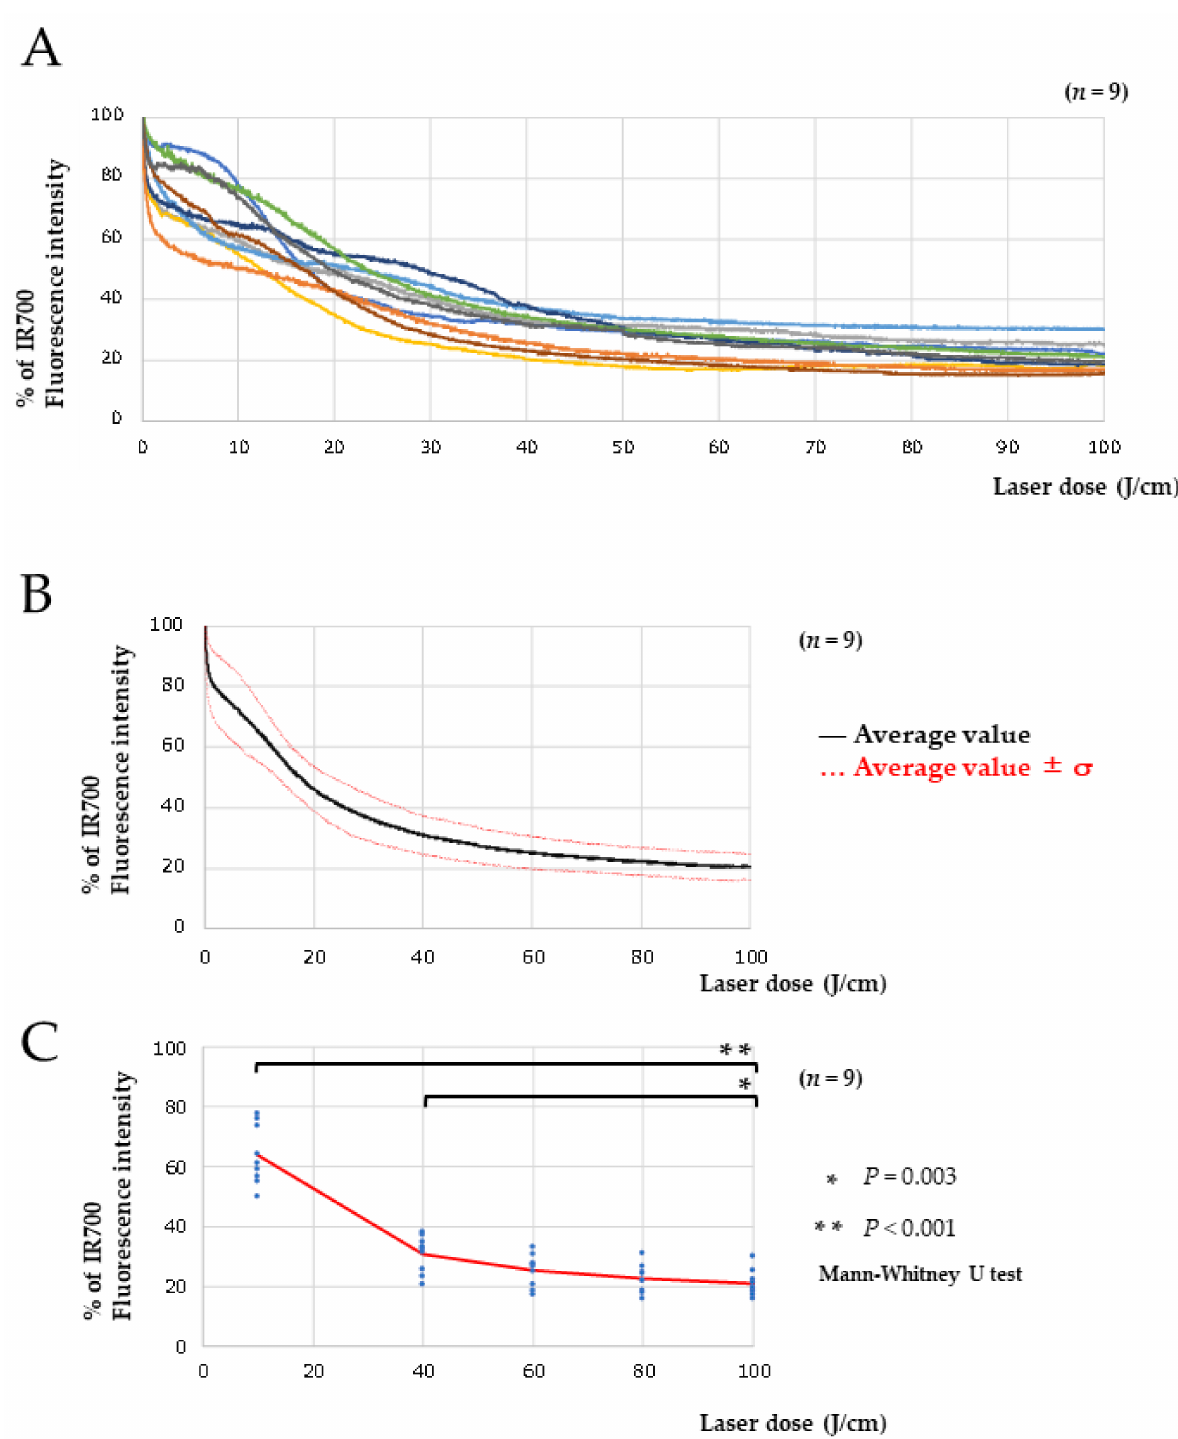
Figure 3. Real-time fluorescence imaging analysis of IR700. ( A ) The time fluorescence intensity curve shows the calculated average fluorescence intensity of Cet-IR700-bound tumors during PIT. ( B ) The mean values of the time fluorescence intensity curves and the mean ± σ (red dots) are shown. ( C ) The rate of decay of fluorescence intensity was compared between the clinical dose of 100 J/cm and the 10, 40, 60, and 80 J/cm groups ( n = 9, p < 0.001, p = 0.003, p = 0.10, and p = 0.51, respectively, analyzed by the Mann–Whitney U